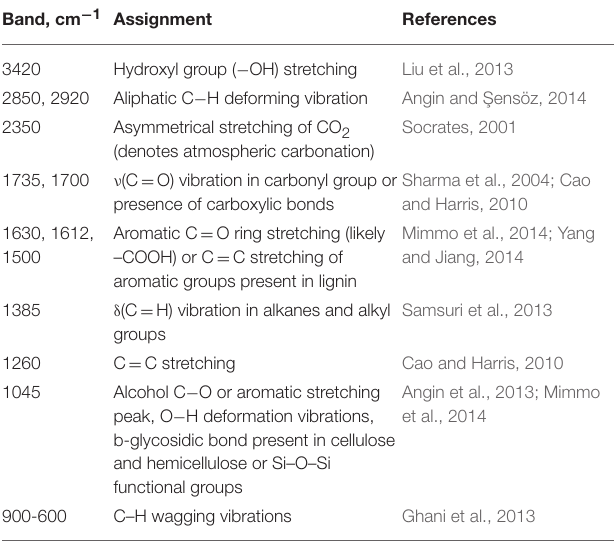
TABLE 2 | FTIR spectra band assignments presented in Figure 3. Band, cm − 1